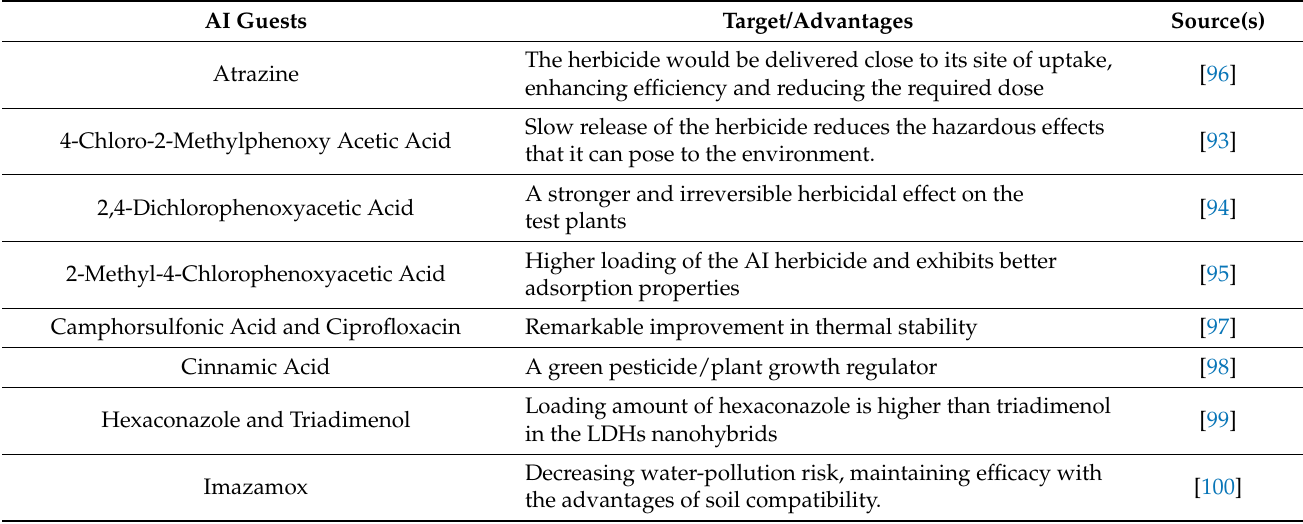
Table 6. Nanopesticides prepared using host–guest supramolecular chemistry based on a Mg/Al-LDH host using various guests, AIs, for various targets and